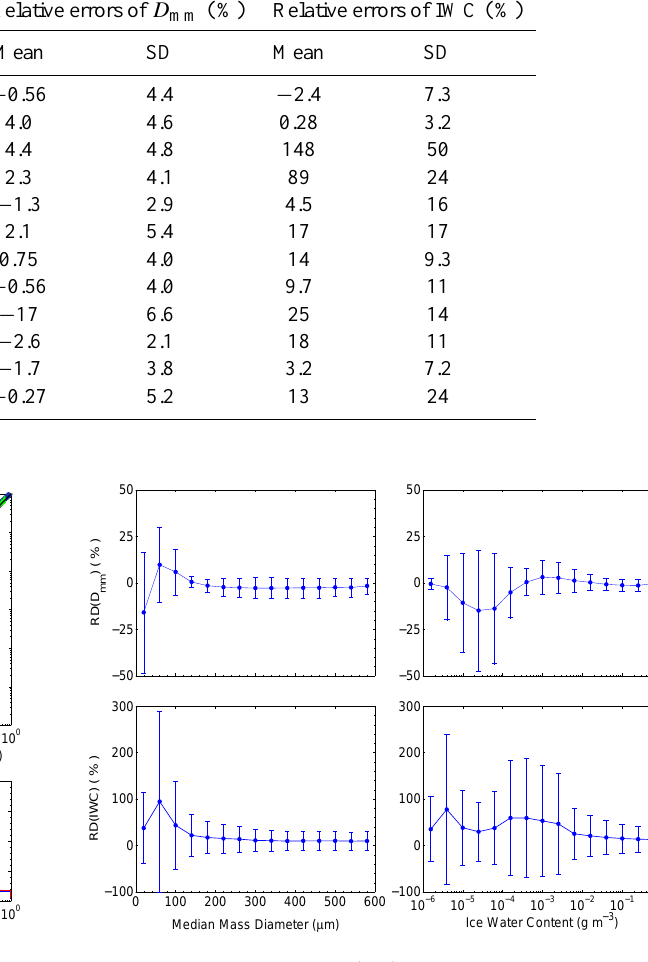
Figure 4. Upper panels: comparison between the measured and cal- culated microphysical properties ( D mm and IWC) for each of the PSDs from 11 field campaigns. Lower panels: Histograms of the distributions of the measured and calculated D mm and IWC.